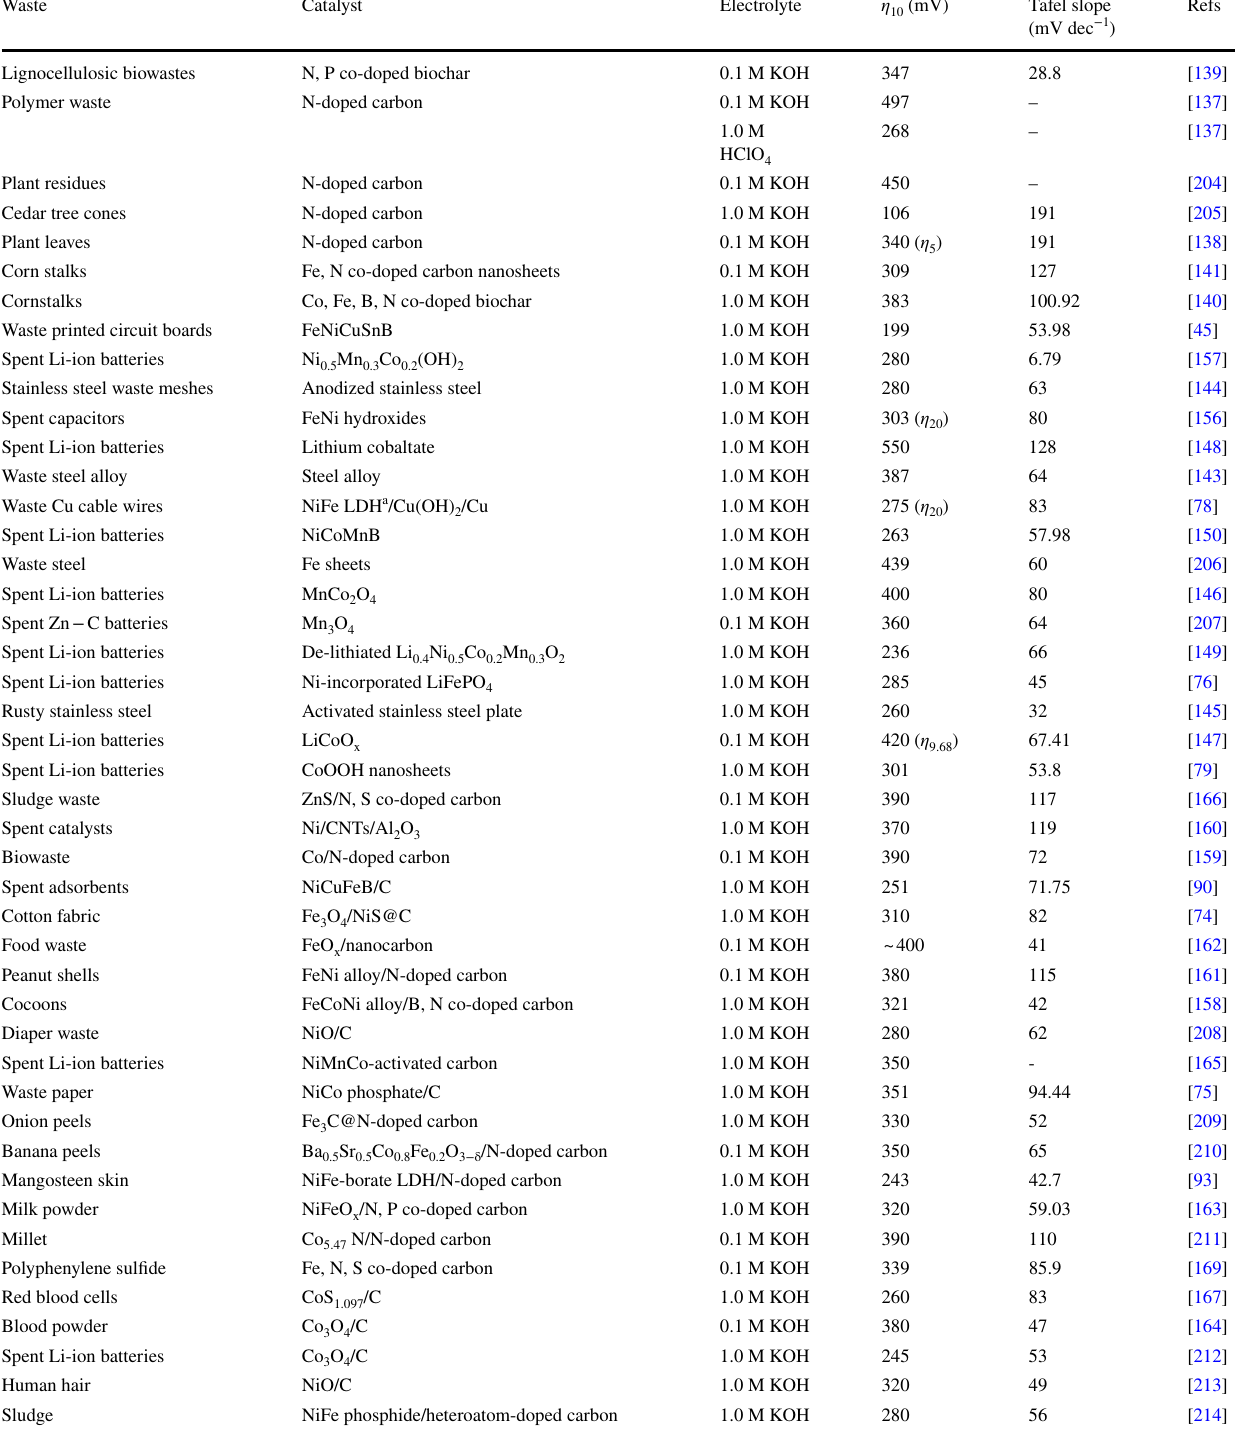
Table 2 Summary of representative waste‑derived OER electrocatalysts